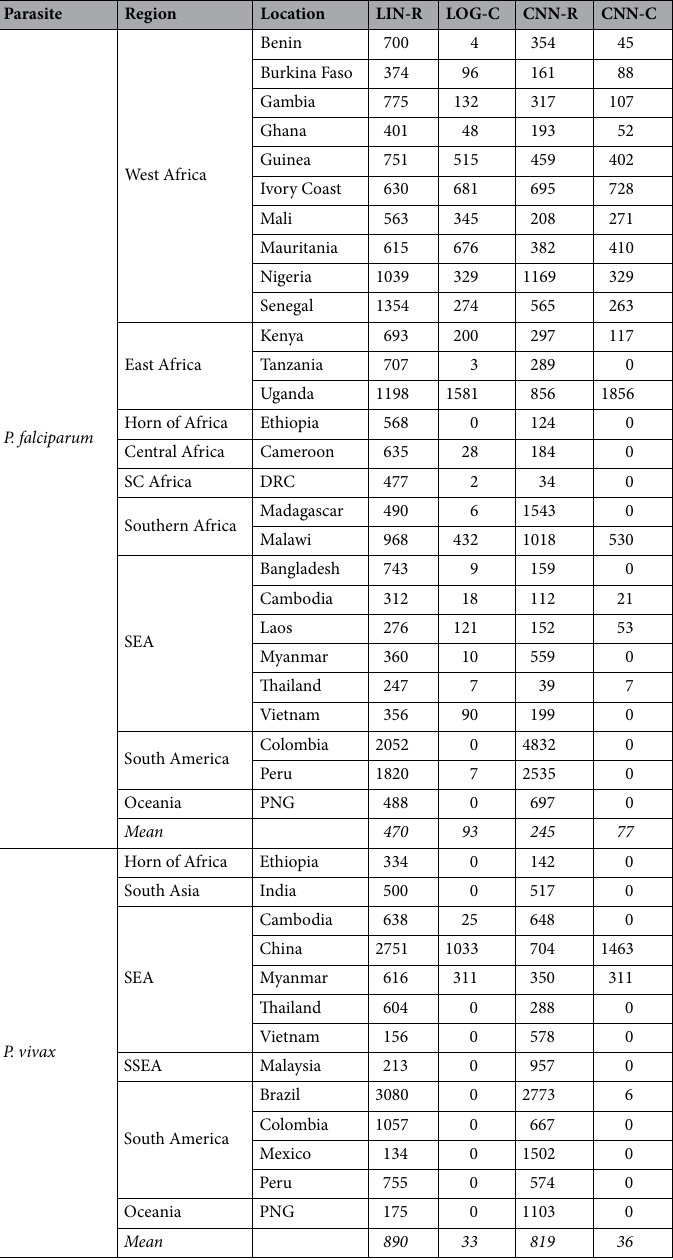
Table 3. Mean distance error (km) per model on test data using those countries included in the training data. DRC Democratic Republic of Congo; PNG Papua New Guinea; CNN Convolutional Neural Network; LOG-C multinomial logistic regression classifier; CNN-C CNN deep learnerclassifier; LIN-R penalised linear regression model; CNN-R Penalised CNN regression model; SC South Central; SEA South East Asia; SSEA Southern